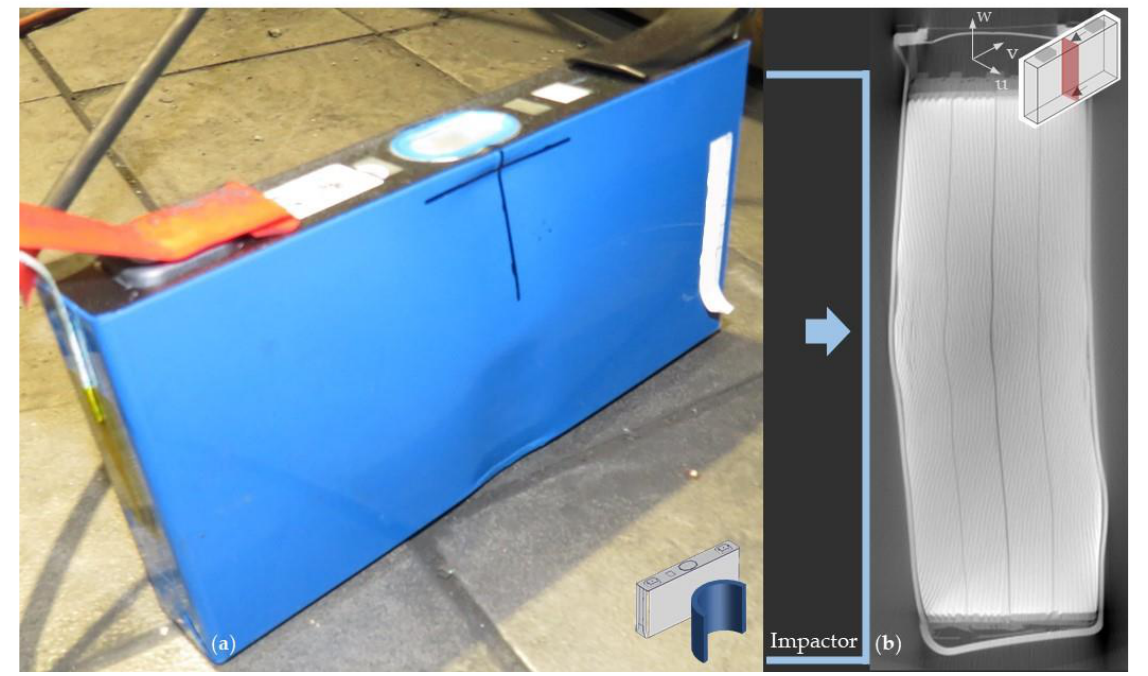
Figure 12. U-direction with cylindrical impactor: ( a ) deformed cell; ( b ) CT-Scan at uw-plane.